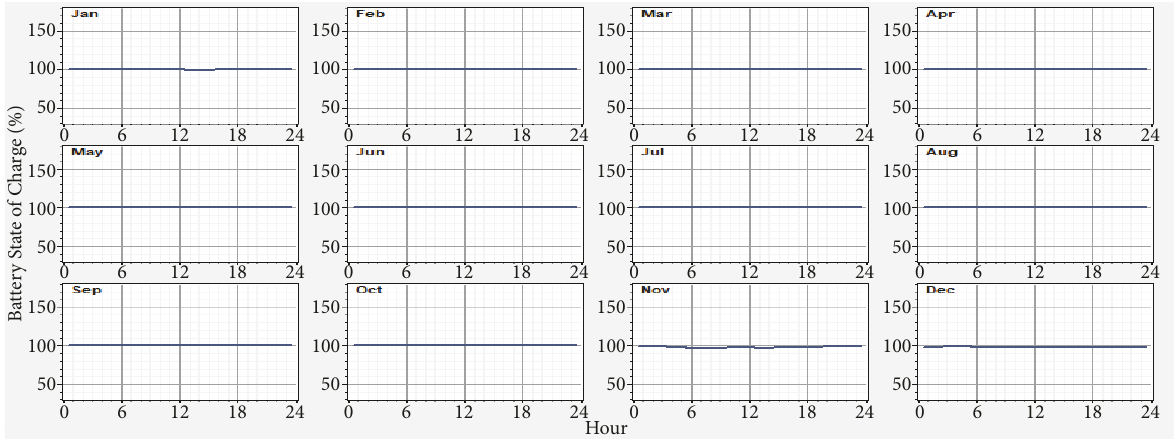
Figure 21: The battery power profile.